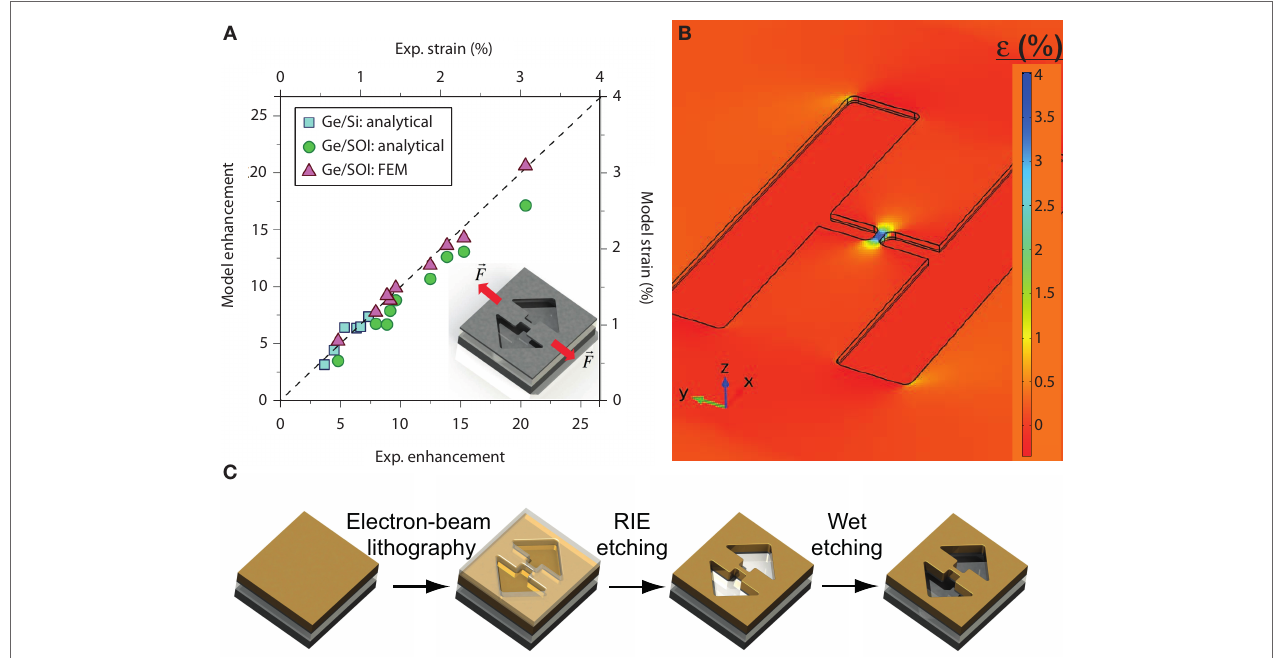
FiGURe 5 | Suspended microbridges from thermally pre-strained Ge . (A) Experimental and modeled strain for Ge microbridges fabricated on Si and SOI. The analytical strain-enhancement model is given in Süess et al. (2013). The enhancement of 22 × corresponds to 3.1% uniaxial strain (Süess et al., 2013).